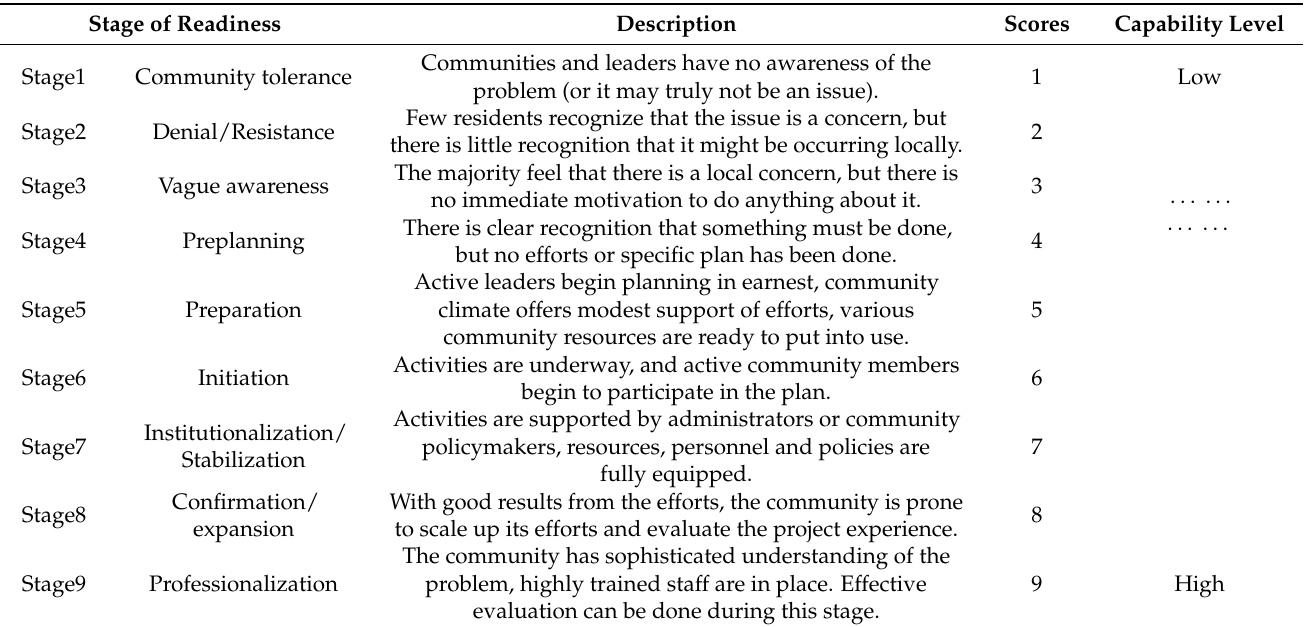
Table 1. Stages of community